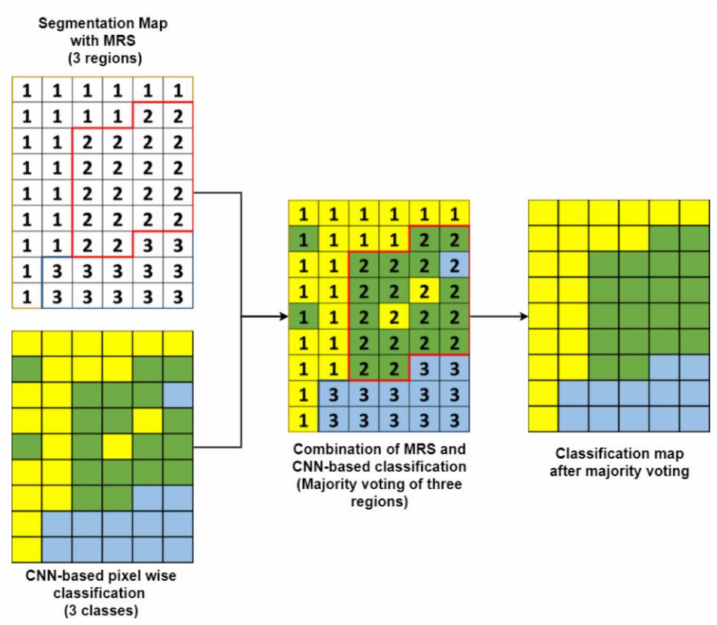
Figure 9. Schematic explanation of majority voting within segmentation.